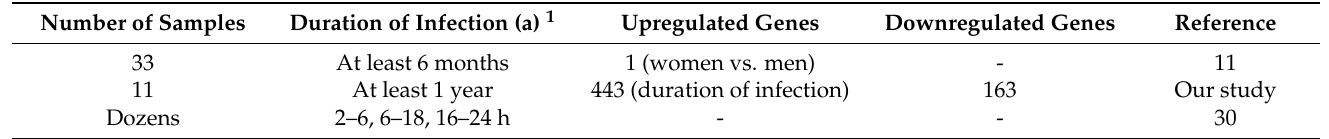
Table 2. Computational approaches aimed at investigation of transcription changes in the course of HIV infection.